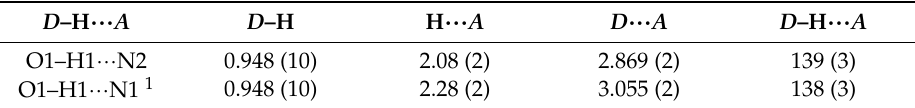
Table 1. Hydrogen bond geometry (Å, °).